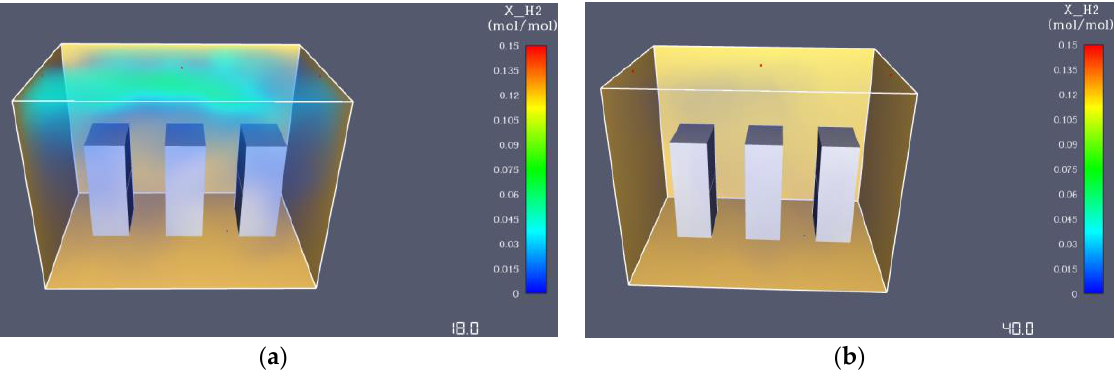
Figure 13. Full pipe rupture at the inlet of the bottom right stack with 120 ACH: ( a ) concentrations at 18 s; ( b ) concentrations at 40 s.